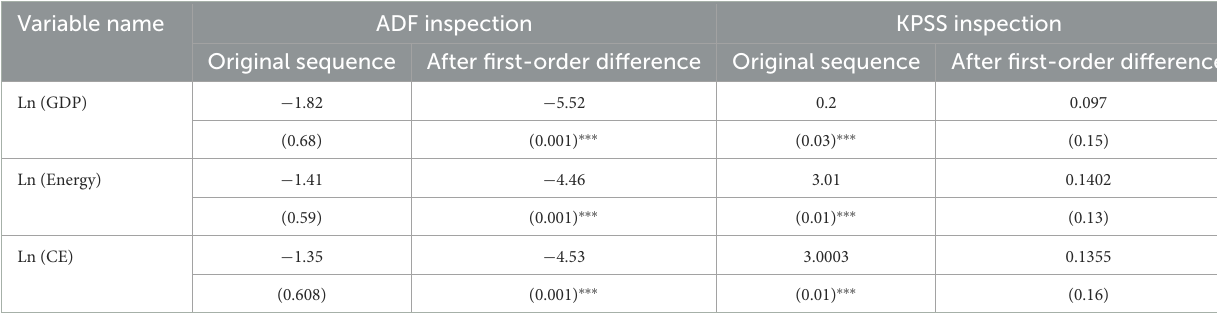
TABLE 3 Test results for